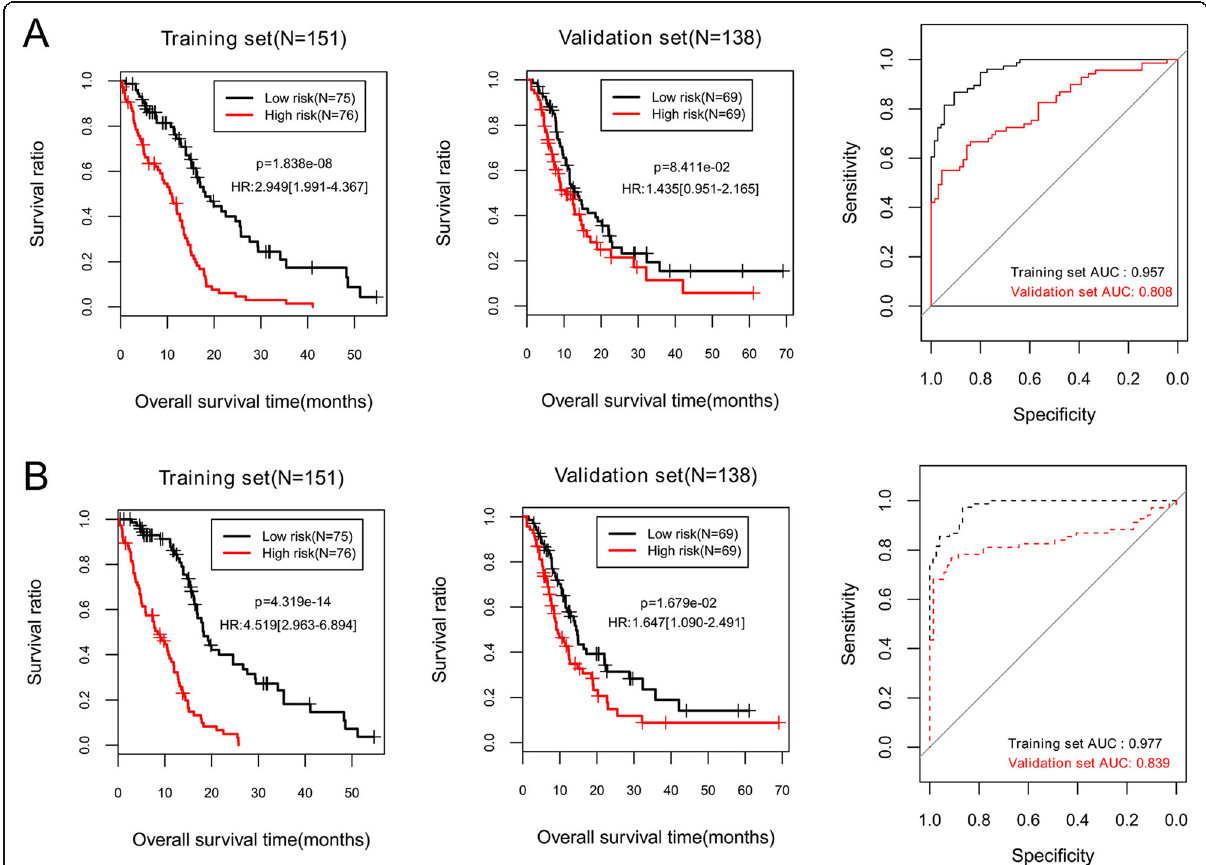
Fig. 3 Kaplan-Meier survival curves and the receiver operating characteristic curve (AUC) to assess predictive ability of the prognosis prediction models based on expression levels of the selected biomarkers in the training set and the validation set. a , selected ten lncRNAs; b , selected eight mRNAs. Each set is separated by each prognostic model into a high-risk group and a low-risk group